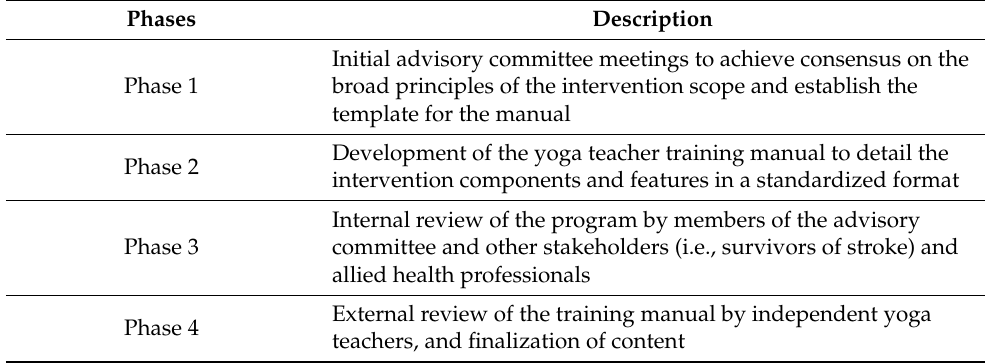
Table 1. The program was developed over four main